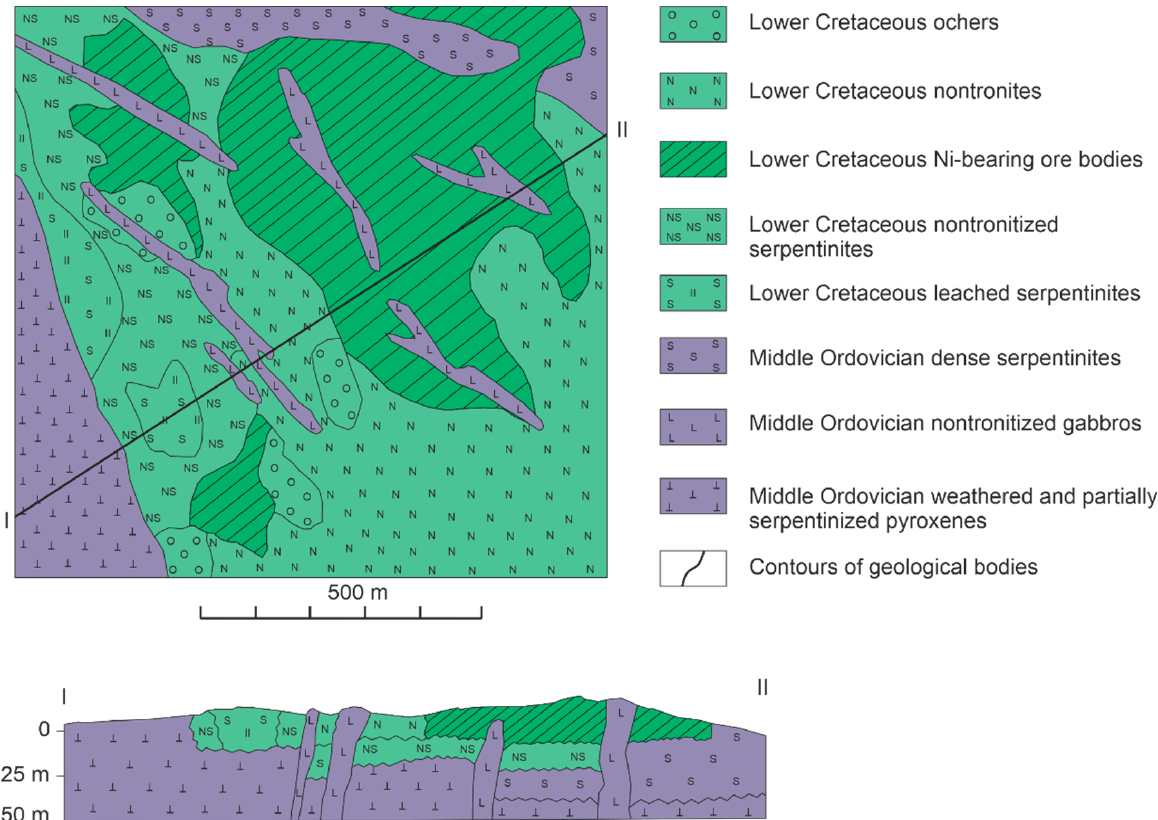
Figure 3. Scheme of the geological structure of the Shelektinskoye deposit. Upper hypergene layer—weathering crust. Lower tier—altered ultramafic rocks.